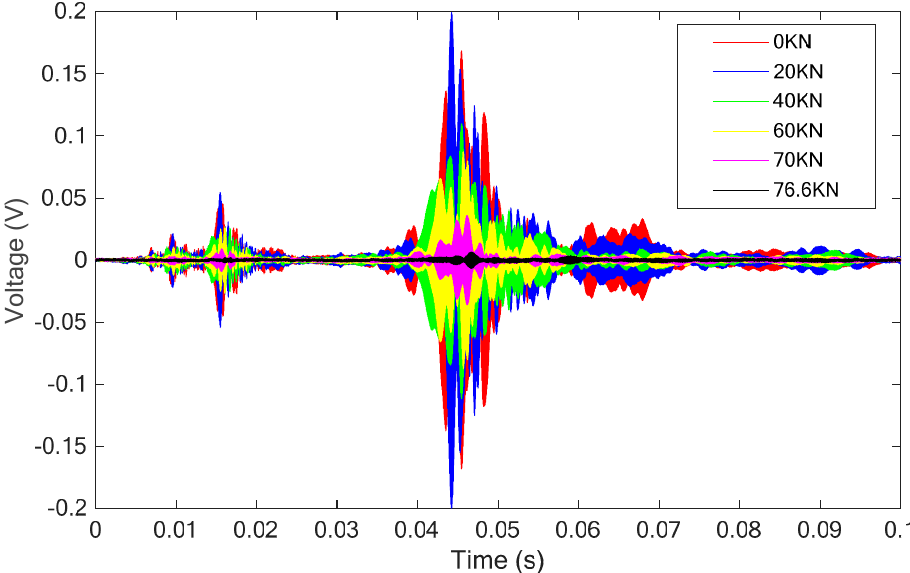
Figure 12. The received signals of the sensor for the specimen with the SCFRP strengthening.